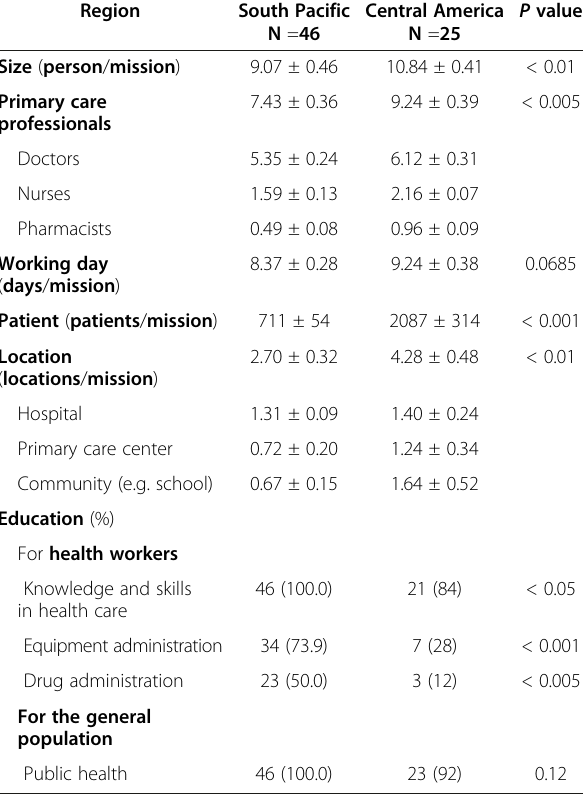
Table 5. There was no significant difference in the demo- graphic data between personnel of the South Pacific and Central America — including in the areas of gender, age, marital status, working experience, academic degree, and profession.